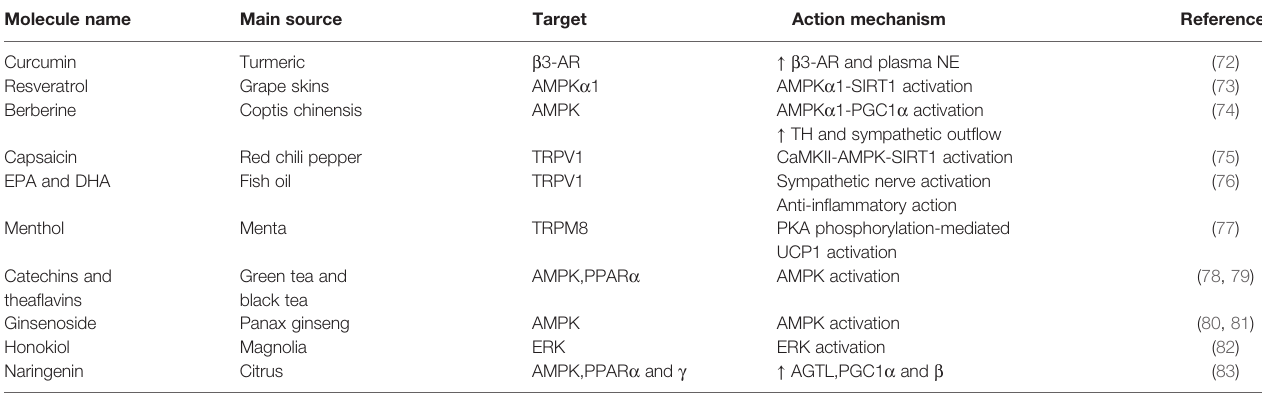
TABLE 2 | Summary of dietary compounds involved in beige